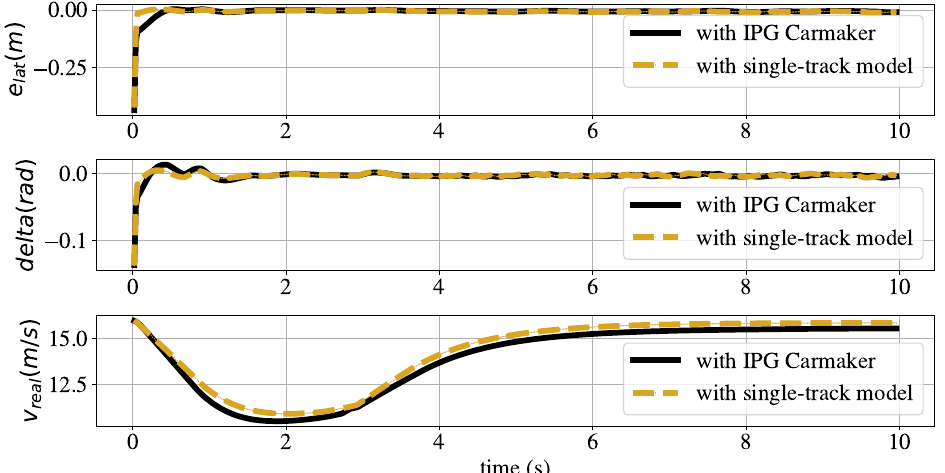
Figure 13. Comparison of the lateral error, the steering angle and the velocity of the ego vehicle for the two different simulation architectures in the original motorway scenario (standard